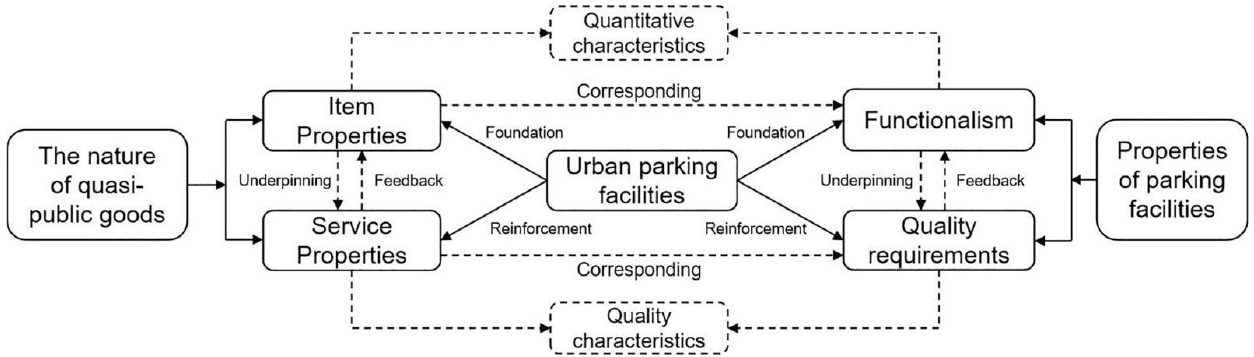
Figure 1. Connotations of attributes of urban parking